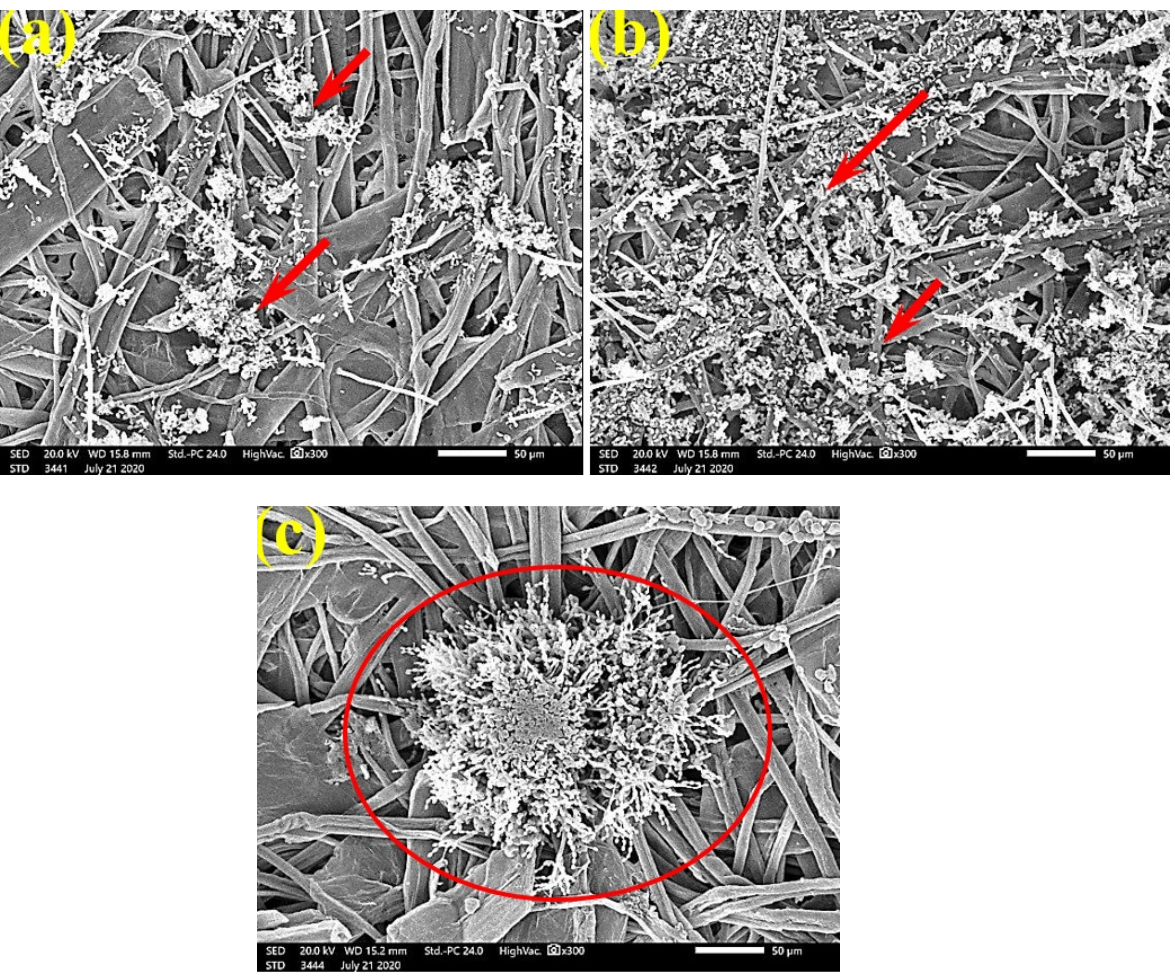
Figure 10. SEM images of paper sheets manufactured from pulps of ( a ) B. speclabilis , ( b ) F. altissima , and (c) F. elastica treated with 0.25% MAHE and inoculated with S. solani . Arrows refer to dense growth of fungal mycelia based on the concentration of the extract and the type of paper sheet pulp.